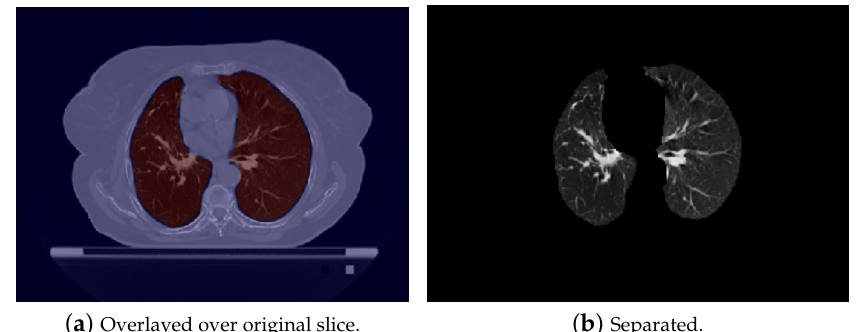
Figure 12. Example of segmented